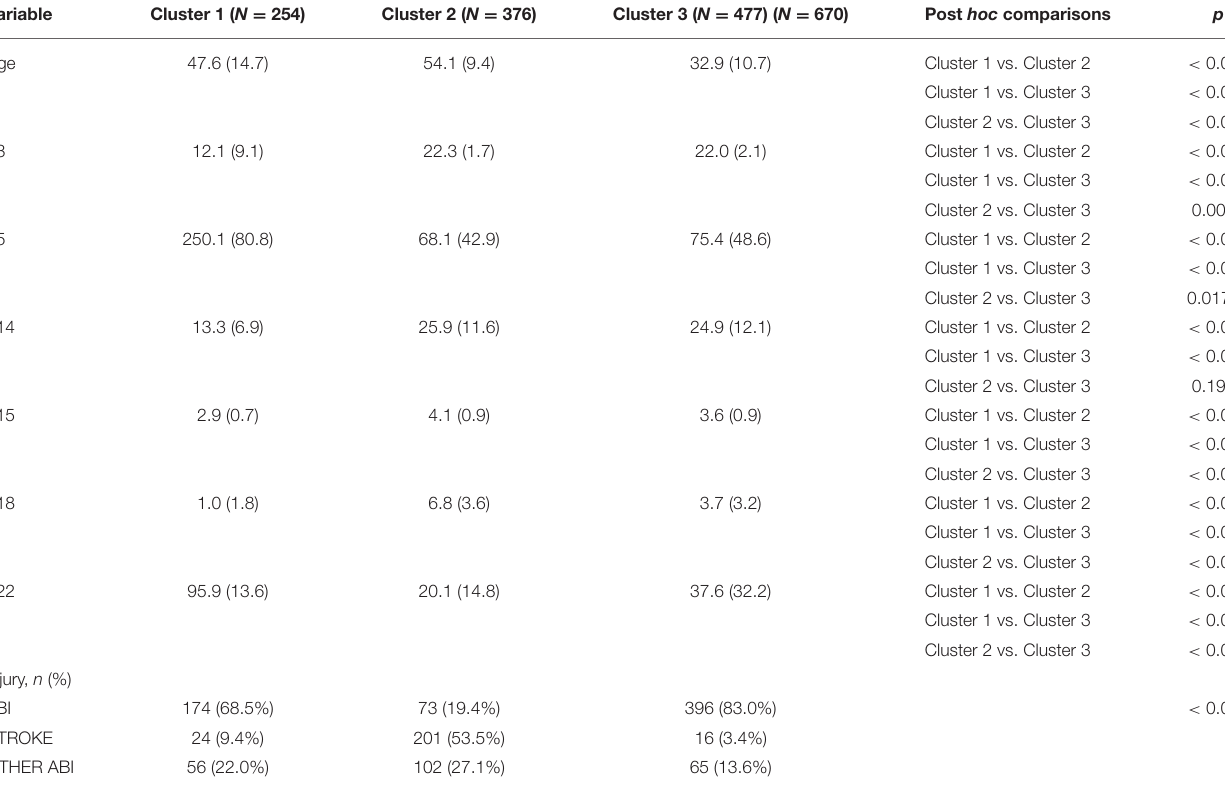
TABLE 4 | Kproto results considering only the variables used for creating the clusters with post hoc analysis.